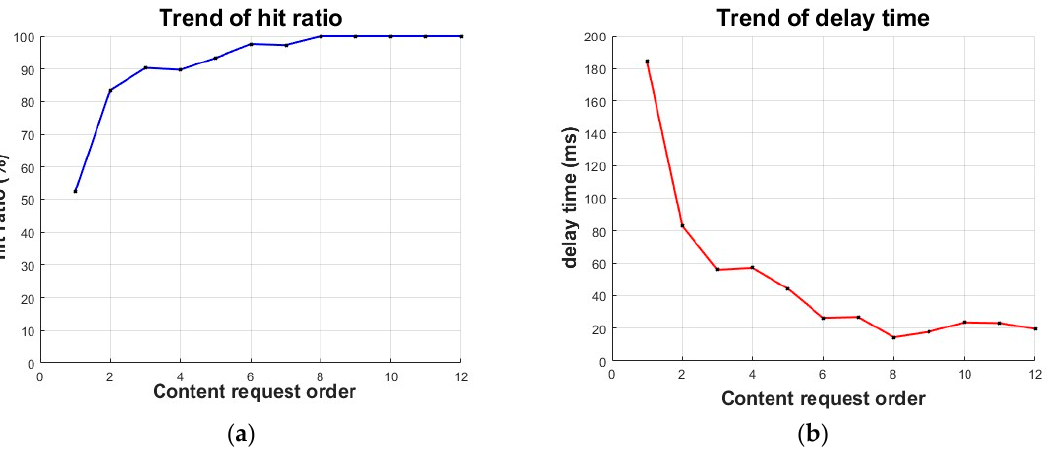
Figure 12. Results of the content request order for the proposed method : ( a ) hit ratio; ( b ) latency.